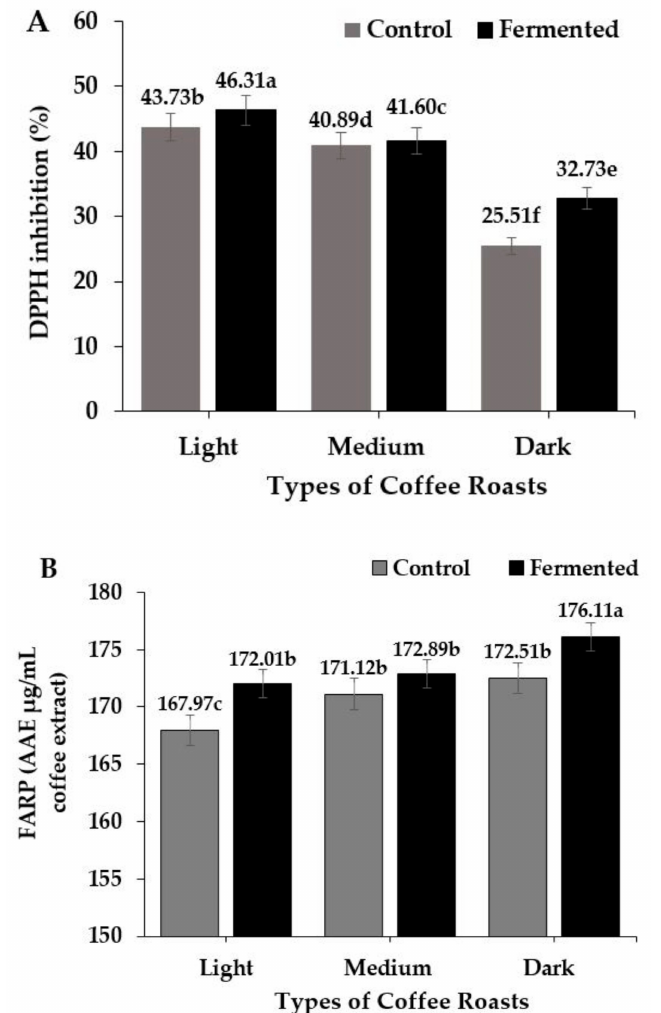
Figure 5. The DPPH inhibition (%) and Ferric reducing antioxidant power (AAE µ g / mL of co ff ee extract) of fermented co ff ee. ( A and B , respectively). Bars with di ff erent letters indicate a significant di ff erence ( p < 0.5) among